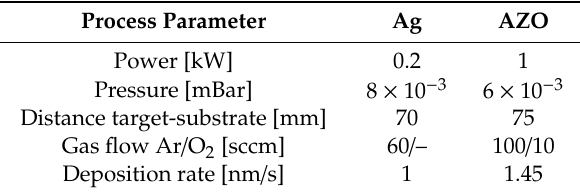
Table 2. The 400 nm AZO front contact for the spectrally selective cell was deposited at 220 Vistaris 600 (Singulus, Kahl am Main, Germany) by DC magnetron sputtering. Table 2. Process parameters for MOMO fabrication.